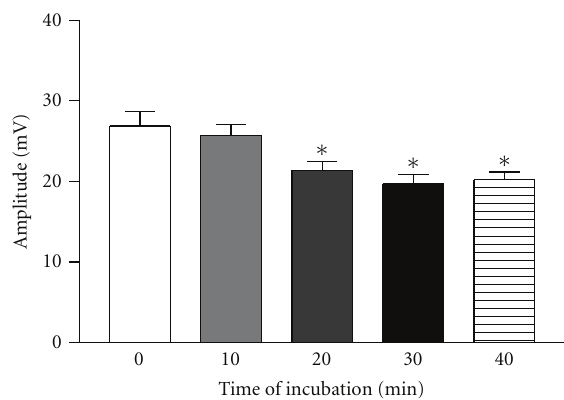
Figure 3: E ff ect of NST (3.57mM) on the CAP amplitude. This figure shows the time-course of NST incubation. The bars indicate the mean ± S.E.M. of 5 experiments. ∗ P < . 05 in relation to absence of NST addition.